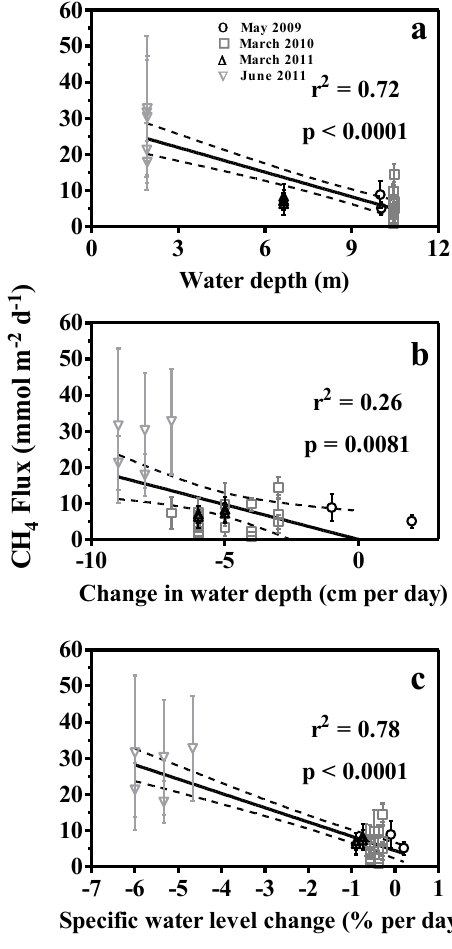
Figure 4. CH 4 emissions measured by eddy covariance (DE EC ) versus (a) water depth, (b) change in water depth, and (c) specific water level change for the four field campaigns. Note that turbines were not started in May 2009, leading to no water level change during that field campaign. In all panels, the solid line is the regression line and the dash lines represent the confidence interval